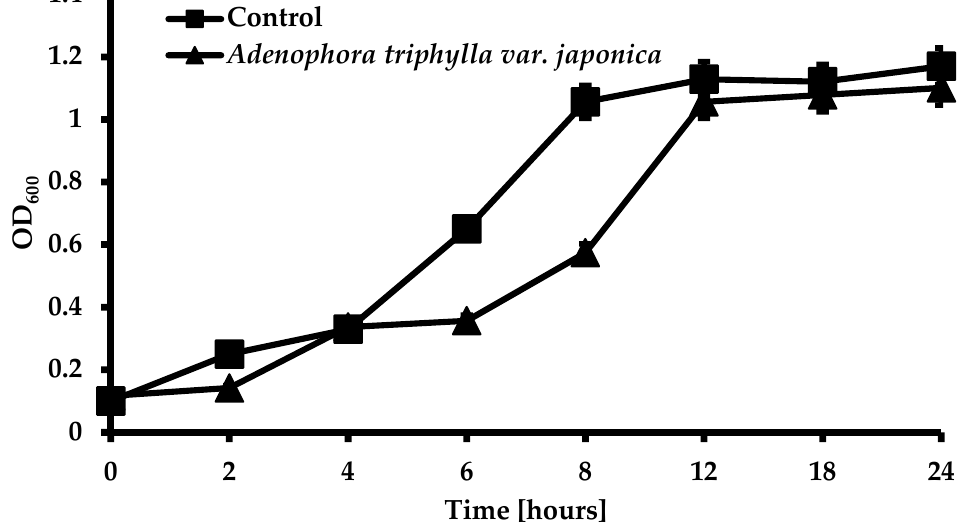
Figure 1. A triphylla var. japonica extract did not inhibit the growth of C. albicans . C. albicans (1 × 10 6 cells/mL) containing 100 μ g/mL of A. triphylla var. japonica extract was incubated for 24 h at 30 °C. Experiments were performed in